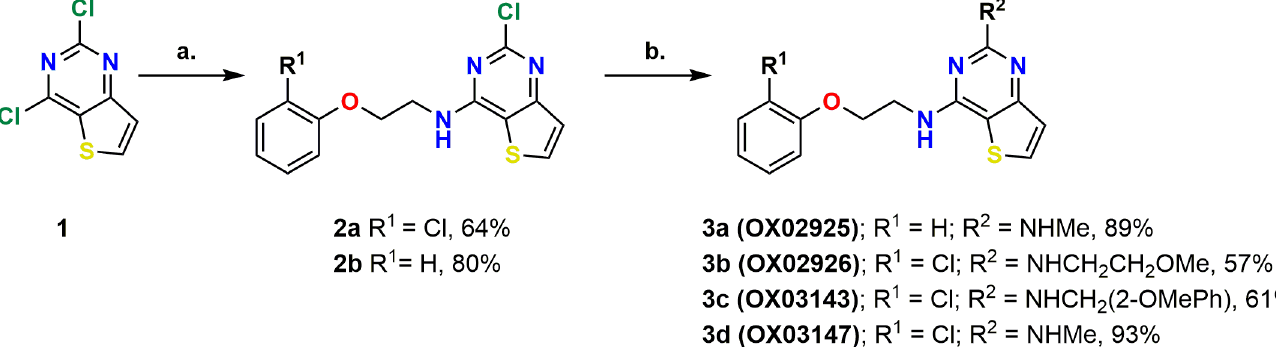
PLOS NeglectedTropical Diseases | https://doi.org/10.1371/journal.pntd.0006487 July 11,